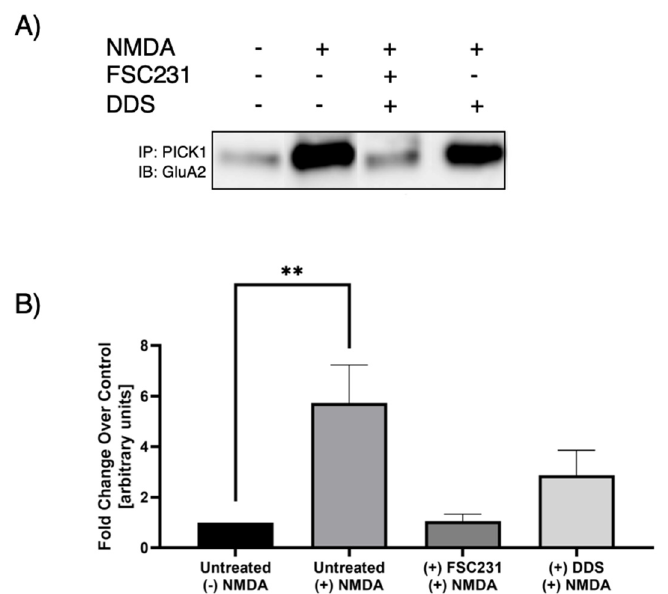
Figure 3. FSC231 prevents NMDA-induced association of GluA2 and PICK1. Fifteen minutes after hippocampal slices underwent 10 min NMDA (20 µM) stimulation, there was an increase in GluA2 association with PICK1. FSC231 treatment prevents this increase in association, whereas empty liposome drug-delivery system (DDS) does not, in hippocampal slices. ( A ) Immunoprecipitation of PICK1, and representative Western blot for GluA2. ( B ) Quantification of Western blots normalized to the unstimulated, untreated samples. N = 3, one-way analysis of variance (ANOVA) with post hoc Sidak; ** denotes p < 0.01; data are expressed as mean ± standard error of the mean (SEM).